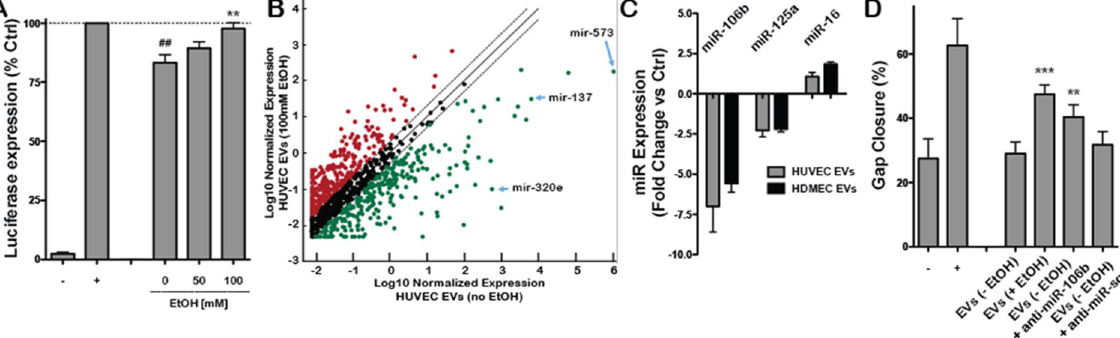
Figure 5. Ethanol (EtOH) regulates endothelial cell-derived EV microRNA content. ( A ) Luciferase expression in recipient HUVECs from a construct containing the 3 ′ untranslated region of CD34 was measured by bioluminescence imaging following stimulation by 100 µ g/ml EVs from producer HUVECs cultured in the presence of the indicated concentrations of EtOH for 24 h (n = 4; ** P < 0.01 vs. 0 mM EtOH condition, ## P < 0.01 vs. positive control ( + ) condition). Mock-transfected HUVEC not exposed to EVs were used as negative controls ( − ), while transfected HUVEC not exposed to EVs were used at the positive control ( + ). ( B ) Average whole miRNome array results comparing miR content of EVs derived from HUVEC cultured in the presence or absence of 100 mM EtOH for 24 h (n = 3). Red dots indicate upregulation of miRs and green dots indicate downregulation of miRs in HUVEC EVs based on producer cell EtOH exposure. Black dots indicate similar expression levels. ( C ) Expression levels of the indicated microRNAs (miRs) in endothelial cell EVs from producer cells cultured in the presence vs. absence of 100 mM EtOH for 24 h was determined by qPCR (n = 3). ( D ) Gap closure of HUVECs was assessed upon stimulated by EVs derived from HUVECs cultured in the absence ( − EtOH) or presence ( + EtOH) of 100 mM EtOH for 24 h following mock transfection or transfection by an antagomir to miR-106b (anti-miR-106b) or a scrambled oligo sequence (anti-miR-scr) (n = 3; *** P < 0.001, ** P < 0.01 vs. EVs ( − EtOH) group). HUVECs incubated in basal medium (EBM2, without growth factors) were used as the negative control ( − ) and HUVECs incubated in growth medium (EGM2, with growth factors) were used as positive controls ( + ).